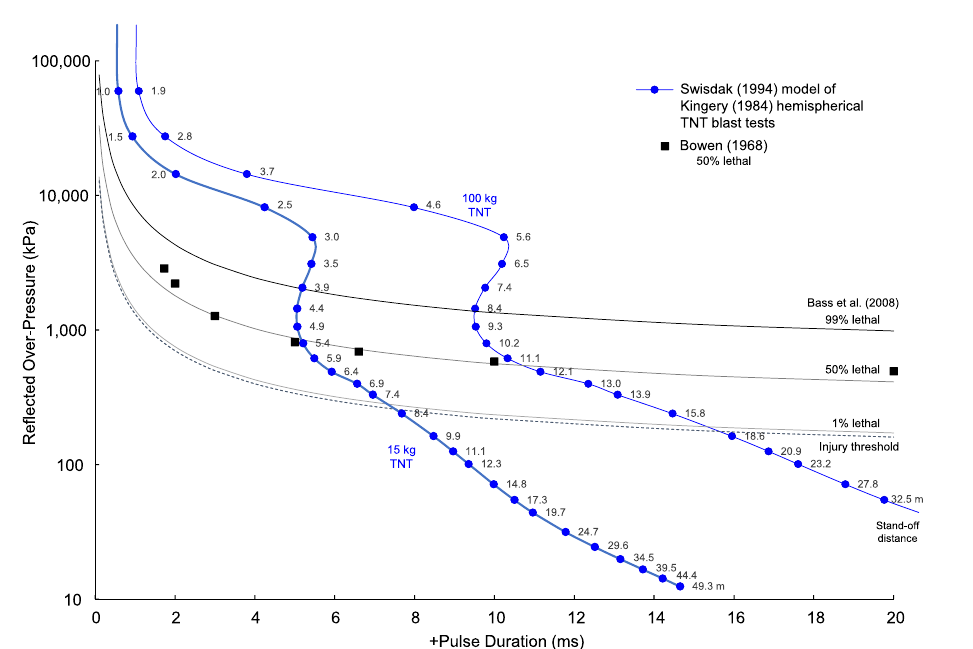
Figure 14. Injury and fatality risks with stand-off distance from reflected shock